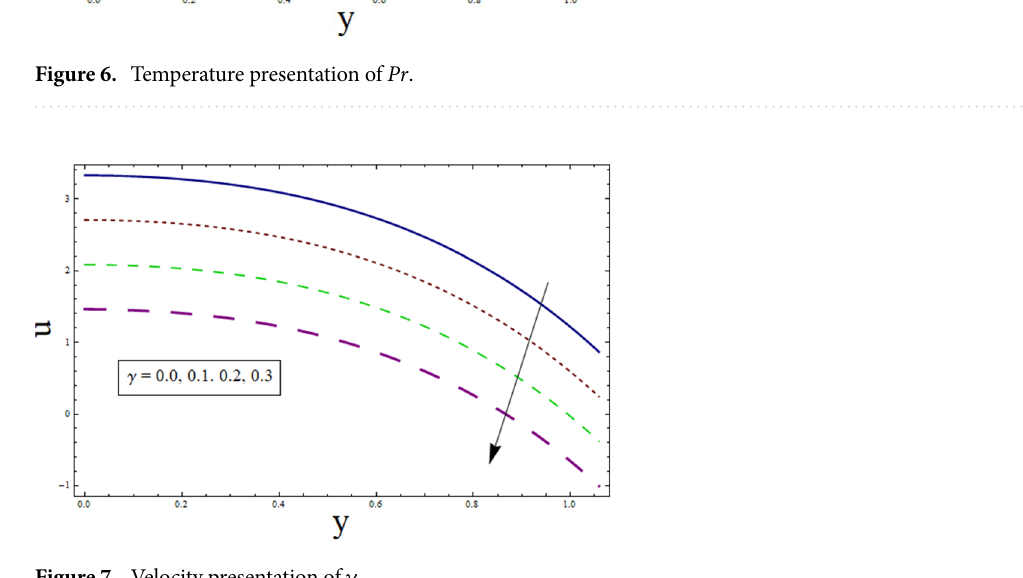
Figure 9 discusses the impact of k on u . Greater the value of suction/injection parameter, larger the number of pores, thus more fluid flow results. Fluid parameter (cid:31) 1 effects the velocity in increasing manner. Since it is viscoe- lastic parameter. Therefore increase in (cid:31) 1 always results in increased elastane causing fluid velocity to increase. (see Fig. 10).